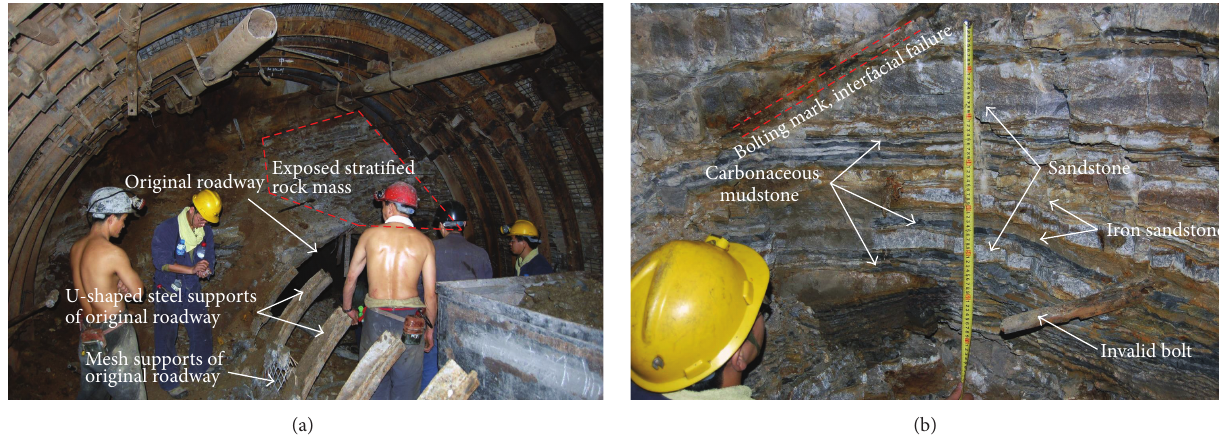
Figure 1: Photos of supporting failure case in Zhuji Mine of Huainan Mining Group. (a) Overview of supporting failure under layered strata occurrence and (b) enlarged view of red dashed polygon in (a), showing bolting failure